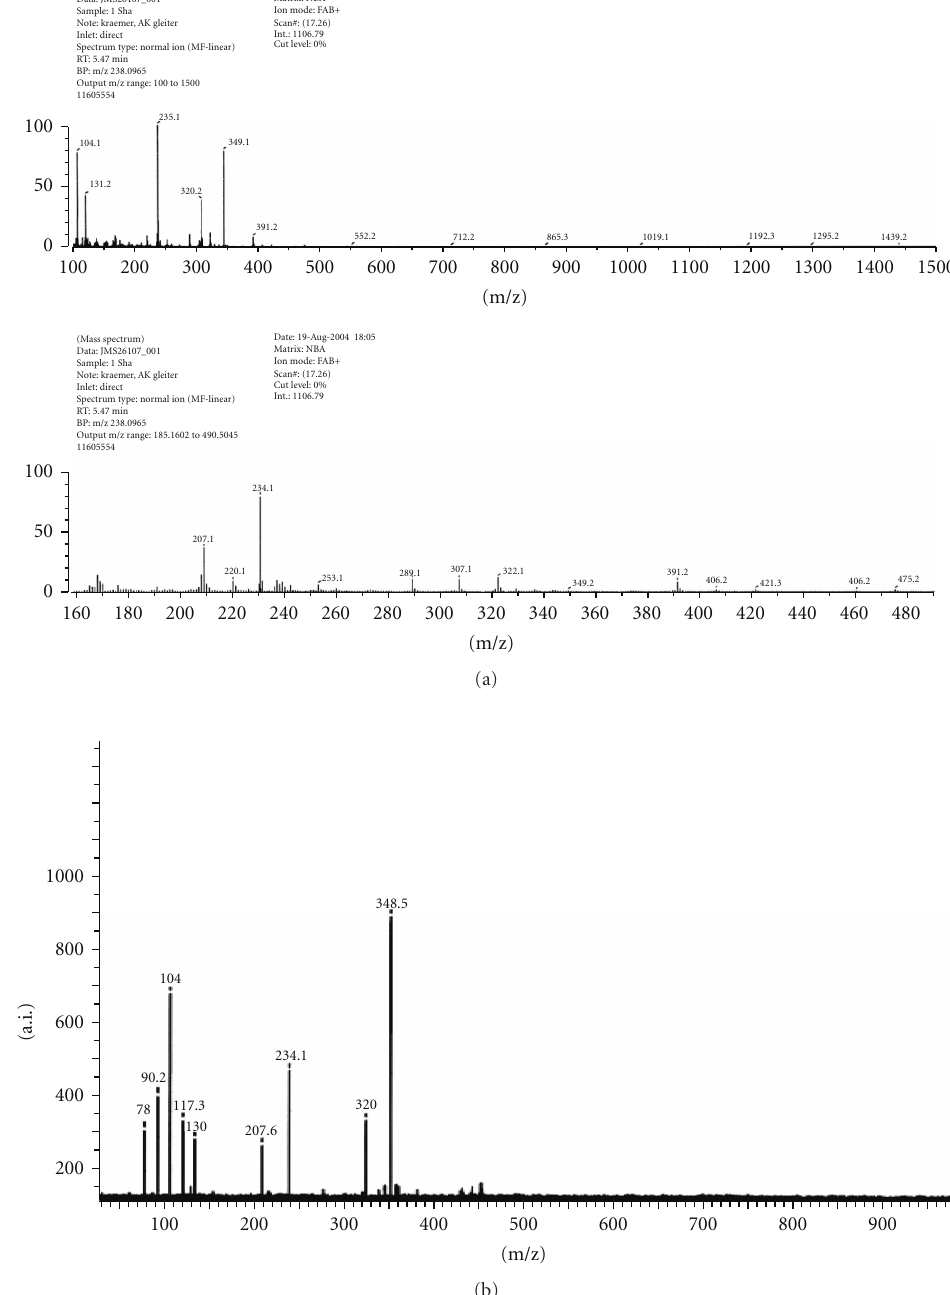
Figure 4: Mass spectrum of L I H by (a) FAB and (b) EI